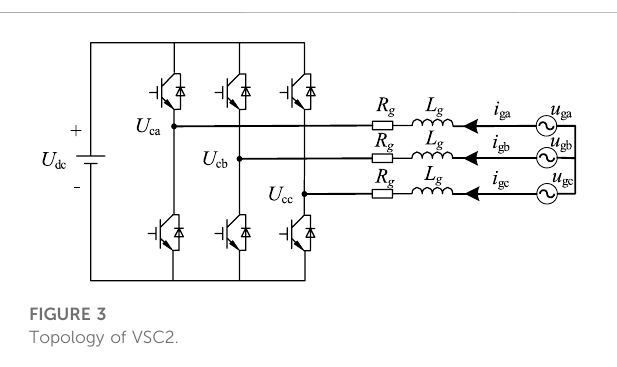
FIGURE 2 Topology of a VSC-HVDC system.